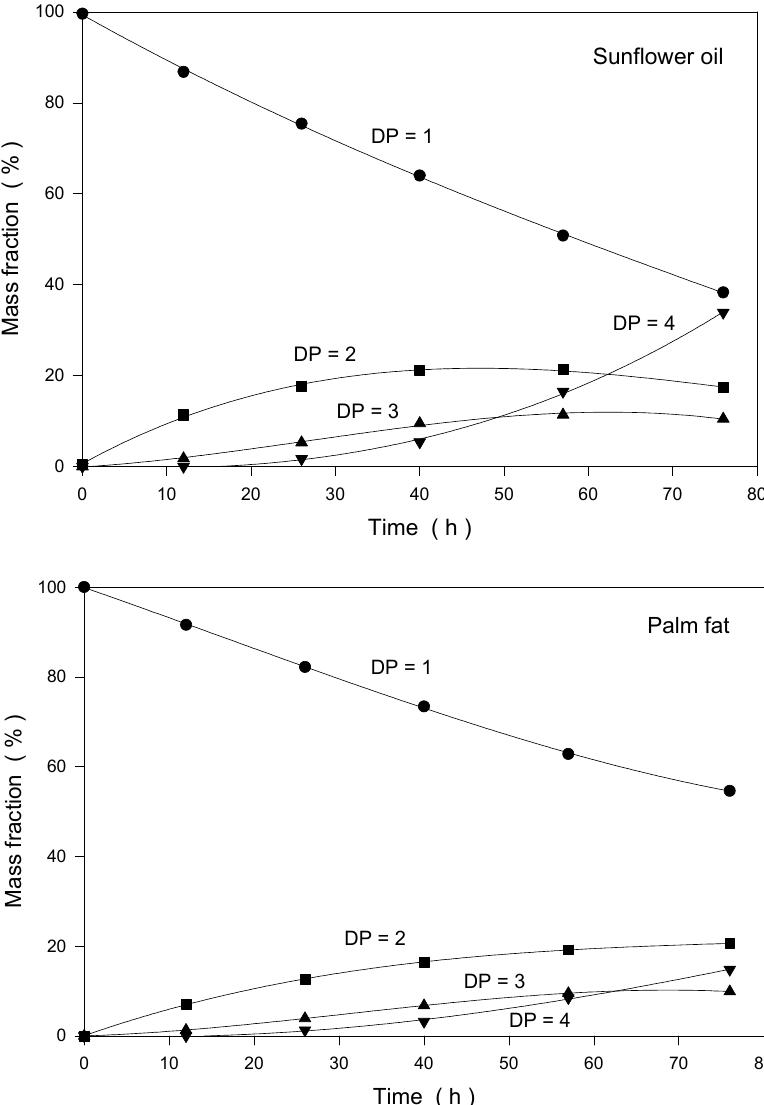
Figure 6. Kinetics of the oligomerization of sunflower oil and palm fat at 175 °C under normal atmosphere; DP = degree of polymerization.